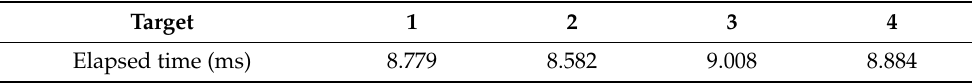
Table 6. Elapsed time of the two-stage fast DOA estimation algorithm for four